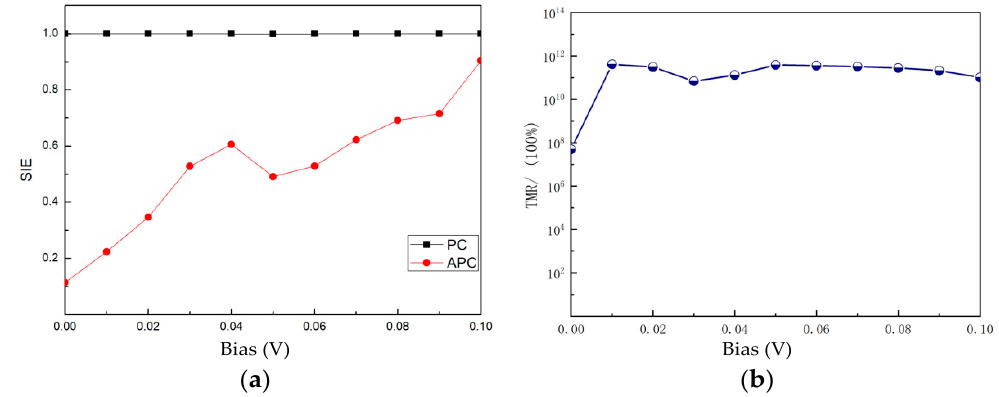
Figure 4. ( a ) Spin-injection efficiency (SIE) and ( b ) tunnel magnetoresistance (TMR) as a function of bias voltage for a PdF 3 based MTJ. × 100%. Figure 4b exhibits the TMR ratio versus bias voltage under equilibrium (cid:12)